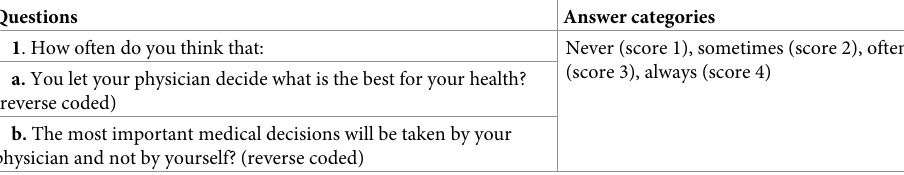
Table 2. Measurement of patient involvement in medical decision-making (based on Flynn et al. 2006